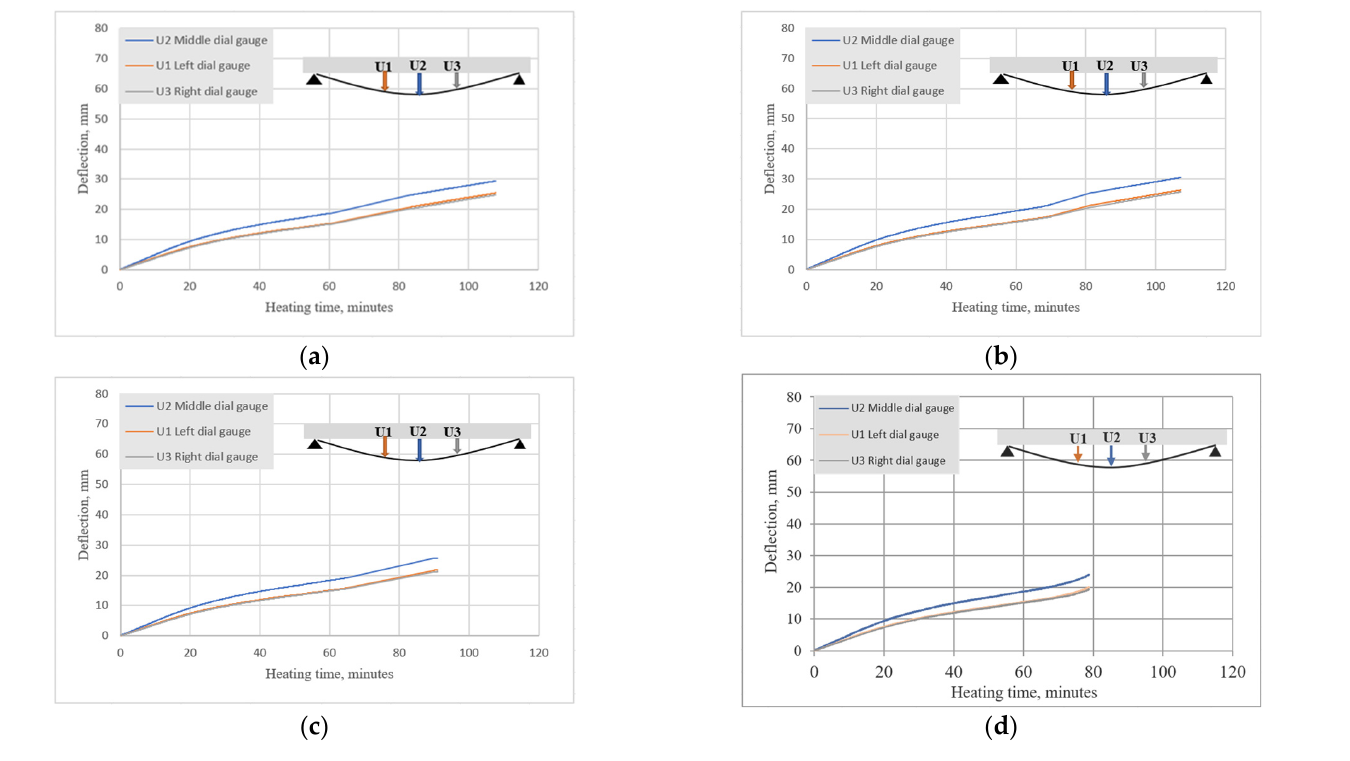
Figure 9. Heating time vs. deflections measured by three dial gauges for set 1.1: ( a ) B2Ø14-beam 1; (b) B2Ø14-beam 2; ( c ) B2Ø14-beam 3; ( d ) set 1-prev: B2Ø14.